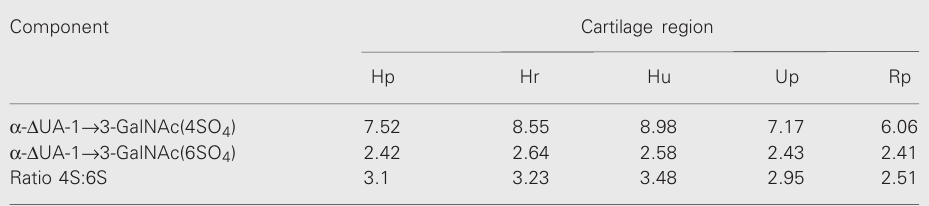
Table 2. Proportions and ratios of 4-sulfated and 6-sulfated disaccharide units in chondroitin sulfate from different regions of chicken wing cartilage. Component Cartilage